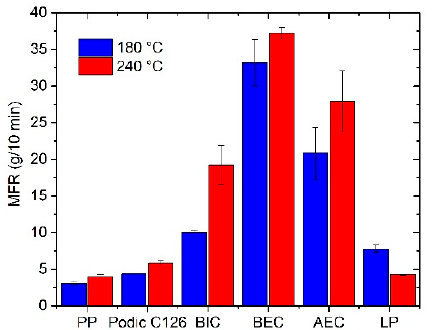
Figure 3. Melt mass-flow rate (MFR) of extruded PP (without peroxide) and modified PP (with different peroxides) at 180 °C and 240 °C; virgin PP has an MFR of 2.8 g/10 min.